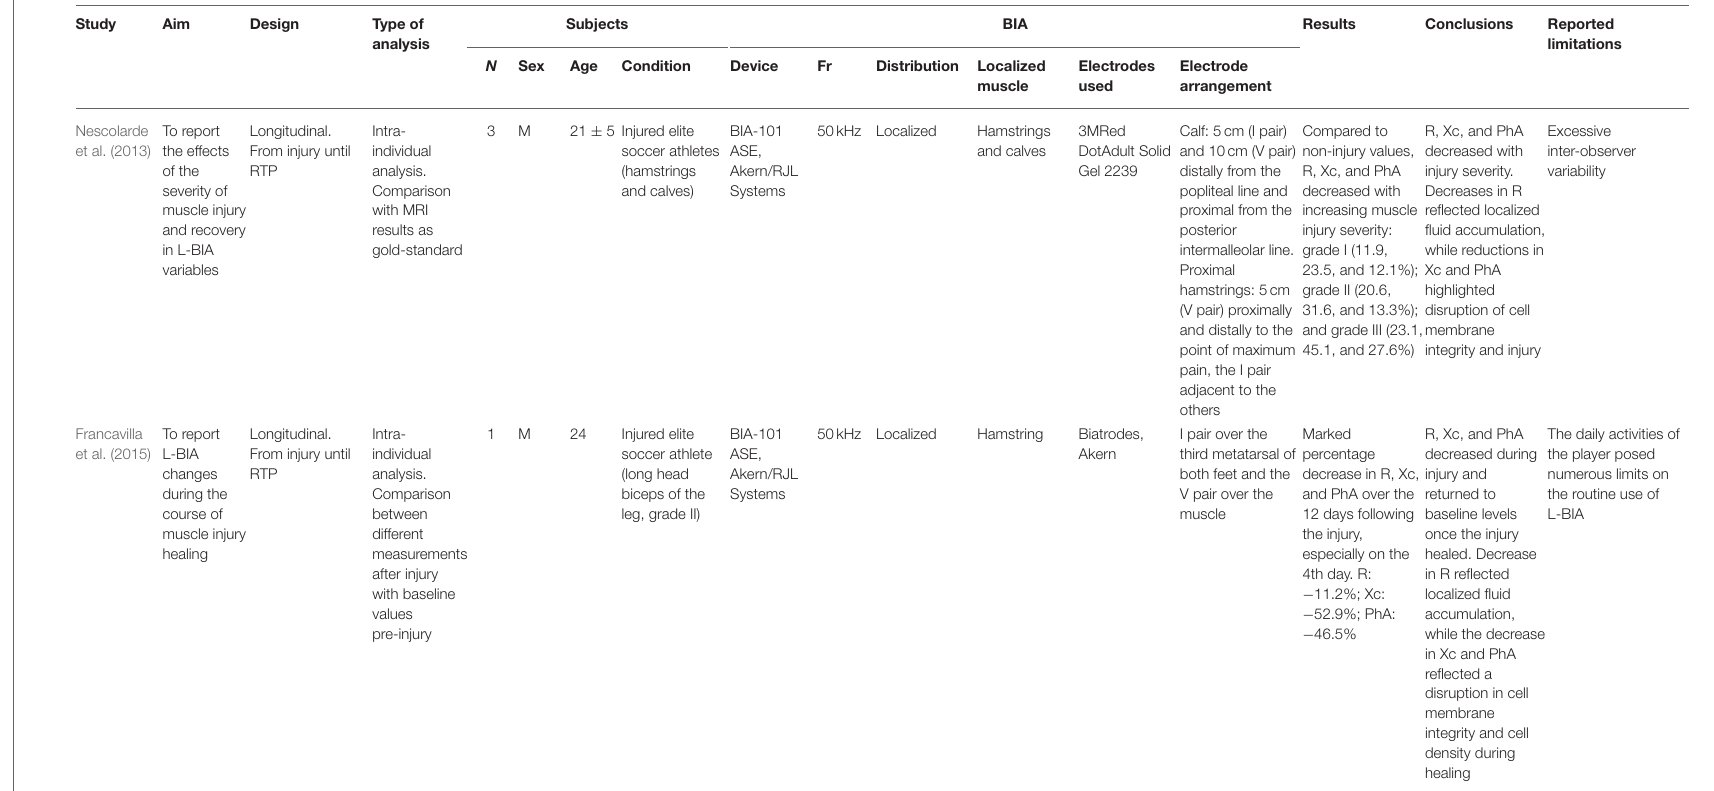
TABLE 2 | EIM studies analyzing skeletal muscle injuries in elite soccer athletes. Study